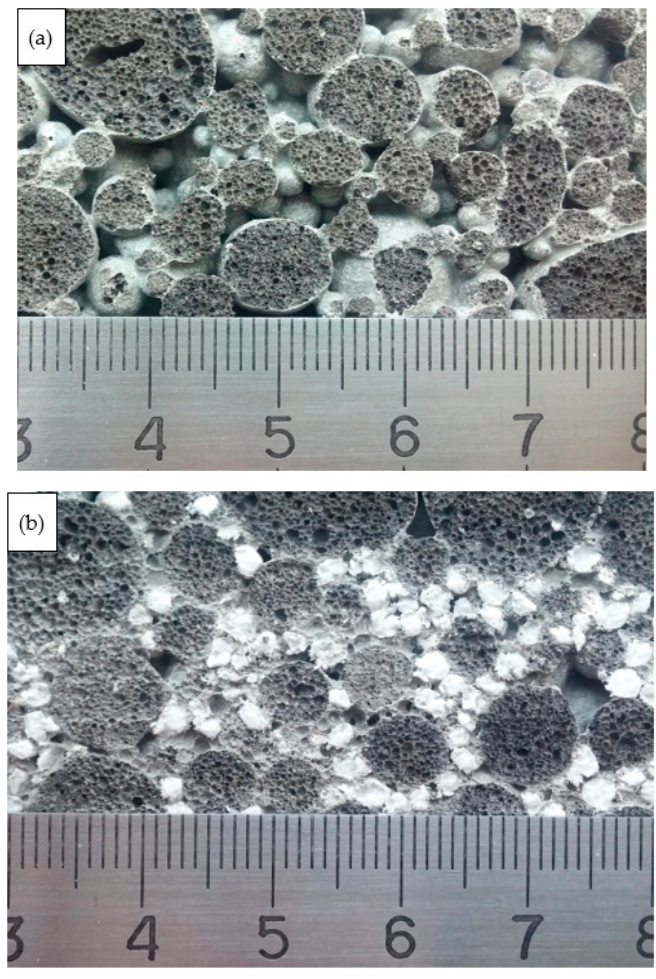
Figure 5. View of the macrostructure of LWC: ( a ) with the EG aggregate; ( b ) with the EG and CEPW aggregate.